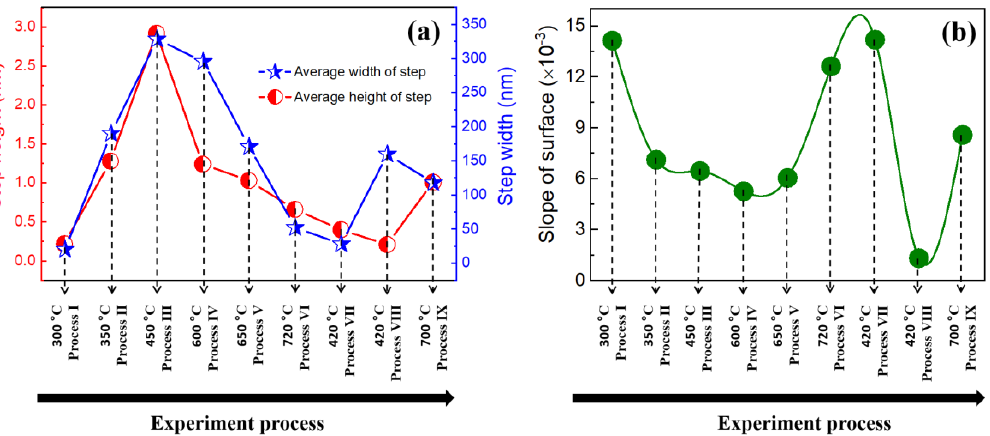
Figure 4. Step height, step width, and “ surface slope ” of the sample surface. ( a ) The changing dependence of average step width and height as a function of annealing process from Process Ⅰ (300 °C) to Process Ⅸ (700 °C); ( b ) the changing dependence of “ surface slope ” as a function of annealing process from Process Ⅰ (300 °C) to Process Ⅸ (700 °C).